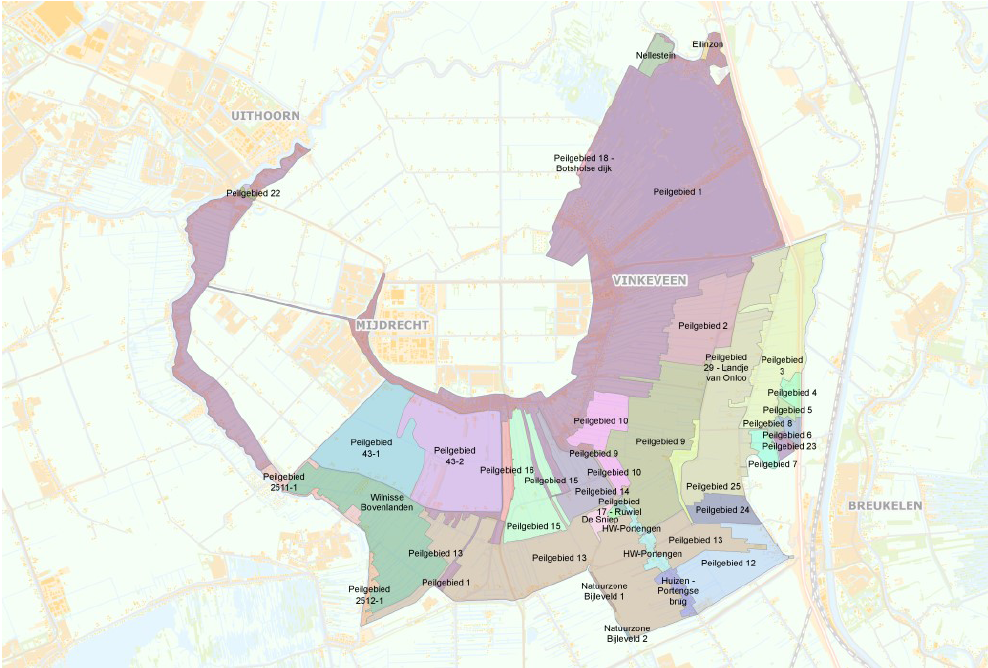
Figure 1. Area of investigation Groot Wilnis-Vinkeveen and Wilnis-Veldzijde, with division into polder subunits (source of topographic underlayer: © Kadaster, 2016).